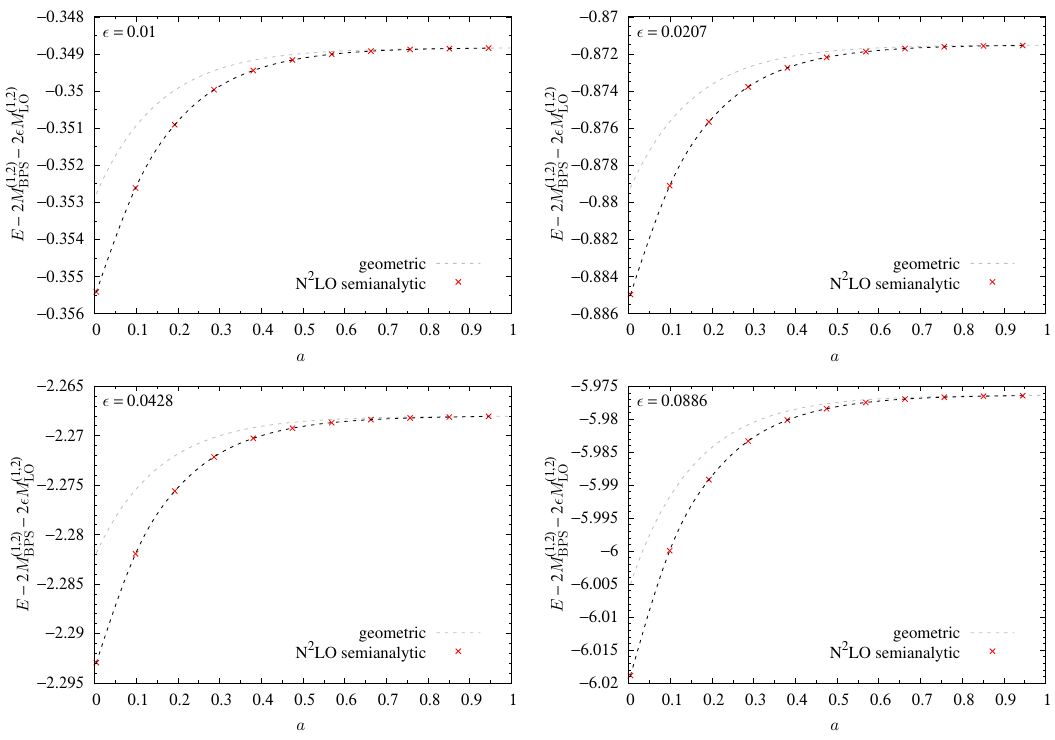
Figure 8 . The N 2 LO corrections to the energy for two B = 1 Skyrmions with separation distance 2 a and (cid:15) = 0 . 01 , 0 . 0207 , 0 . 0428 , 0 . 0886 . Asymptotically, i.e. for large values of a , the N 2 LO cor- rections to the energy become exactly two times those of section 3.4. When a tends to zero, the binding energy increases monotonically with a maximum at a = 0 , for all values of the perturbation parameter (cid:15) . A geometric effect of the binding energy lies simply in part of the tail energy of the B = 1 solutions are cut at the mirror surface x = 0 so as not to over count the B = 1 energies. This reduction of the energy is displayed as geometric with a gray dashed line. The numerical computations are always slightly below the geometric corrections. In this figure c 2 = 1 , c 4 = 8 , c 6 = 1 , µ = 1 , m π = 3 , R = (3 π ) 1 3 and ( s, p ) = (1 , 2) 2